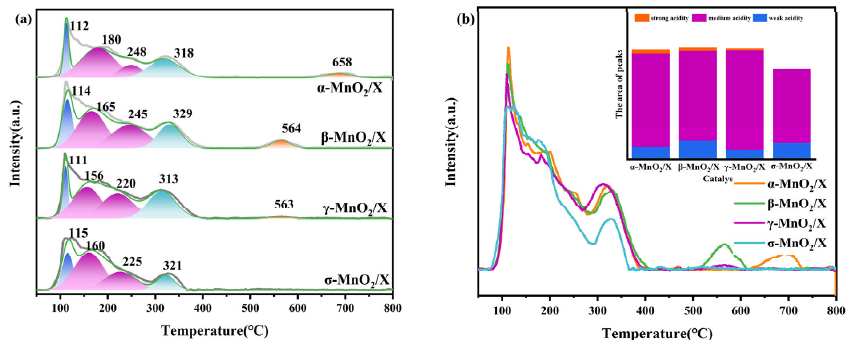
Figure 3. ( a ) NH 3 -TPD profiles and ( b ) the related peaks analysis of α -MnO 2 /X, β -MnO 2 /X, γ - MnO 2 /X, and σ -MnO 2 /X catalysts, and all the curves for NH 3 -TPD over catalysts are shown in the same baseline, which could be a better way to compare the peaks’ intensity and position.